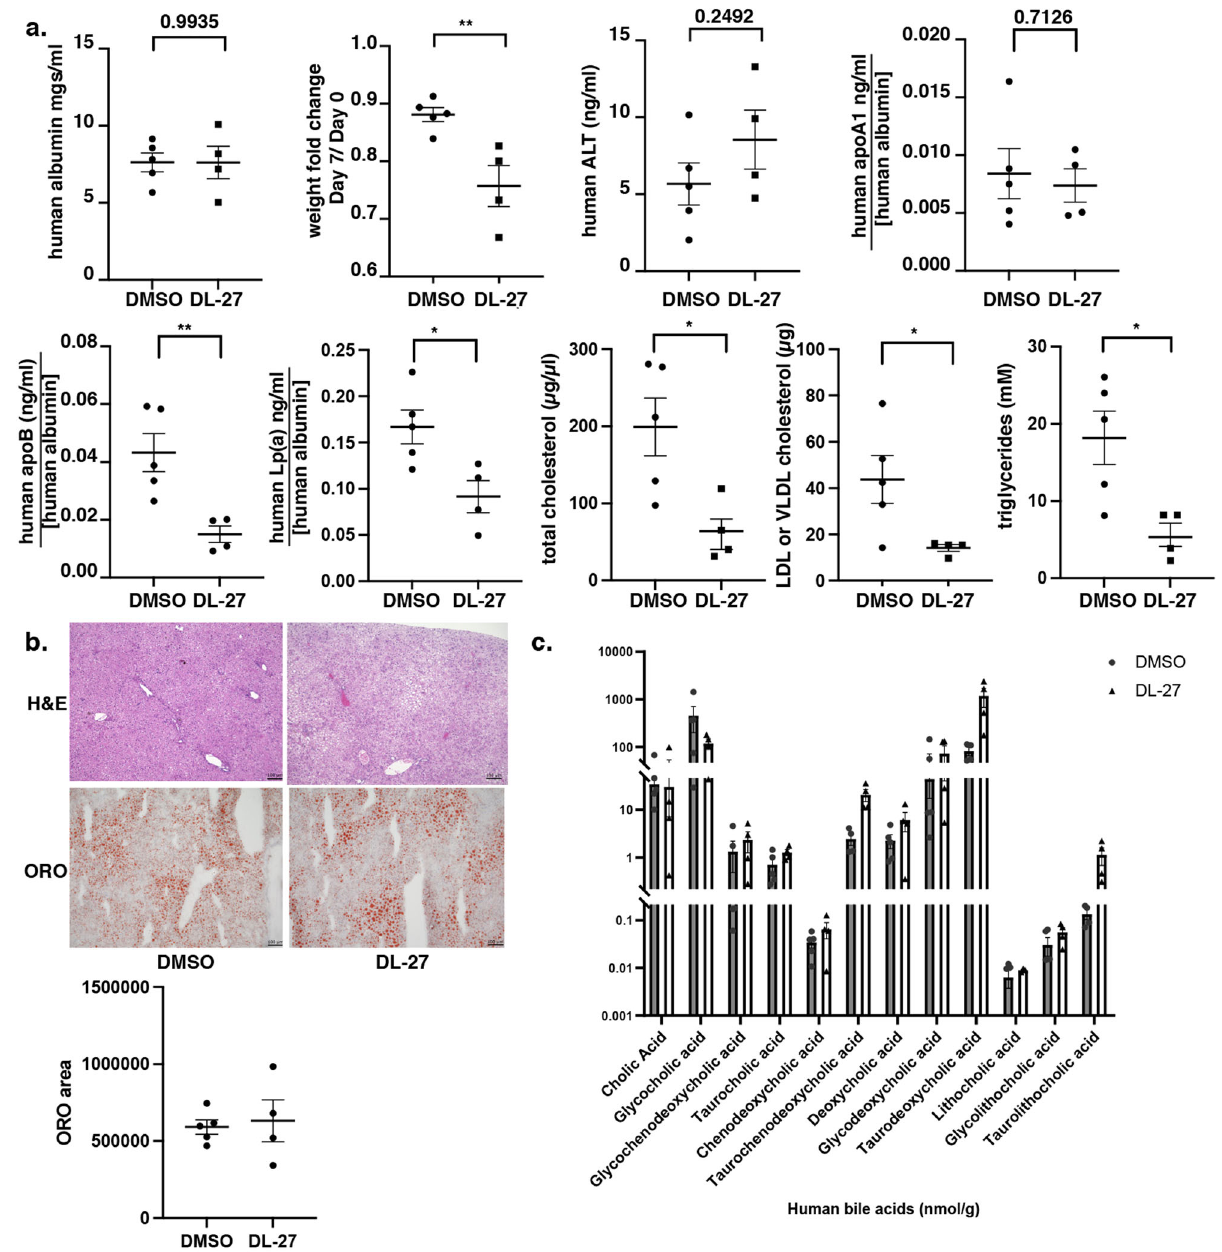
Fig. 8 Triazine thiols are effective in liver-humanized mice. a Graphs showing weight changes during the course of the experiment and serum levels of albumin, ALT, apoA1, apoB, Lp(a), total cholesterol, LDL/VLDL, and triglycerides in liver-humanized mice following 7 days of treatment with either vehicle (DMSO; n = 5) or DL-27 at 20 mg/kg/day ( n = 4). ELISA assays for albumin, apoA1, apoB, and Lp(a) were speci fi c to human proteins and were normalized to human albumin levels to account for variation in the number of human hepatocytes present in each animal at the completion of dosing. Statistical analysis was performed using t tests; * p < 0.05, ** p < 0.01, *** p < 0.001. b Micrographs showing H&E and Oil Red O stained sections through livers of liver-humanized mice treated with vehicle (DMSO) or the triazine thiol DL-27. Quanti fi cation of Oil Red O across representative liver sections in each mouse used in a was determined using ImageJ and shown graphically as the cumulative area of Oil Red O staining. c Bar graphs showing the quantity of 12 different bile acids in the livers of the humanized mice treated with DMSO or DL-27. Levels were determined using LC/MS metabolomics and displayed as a log